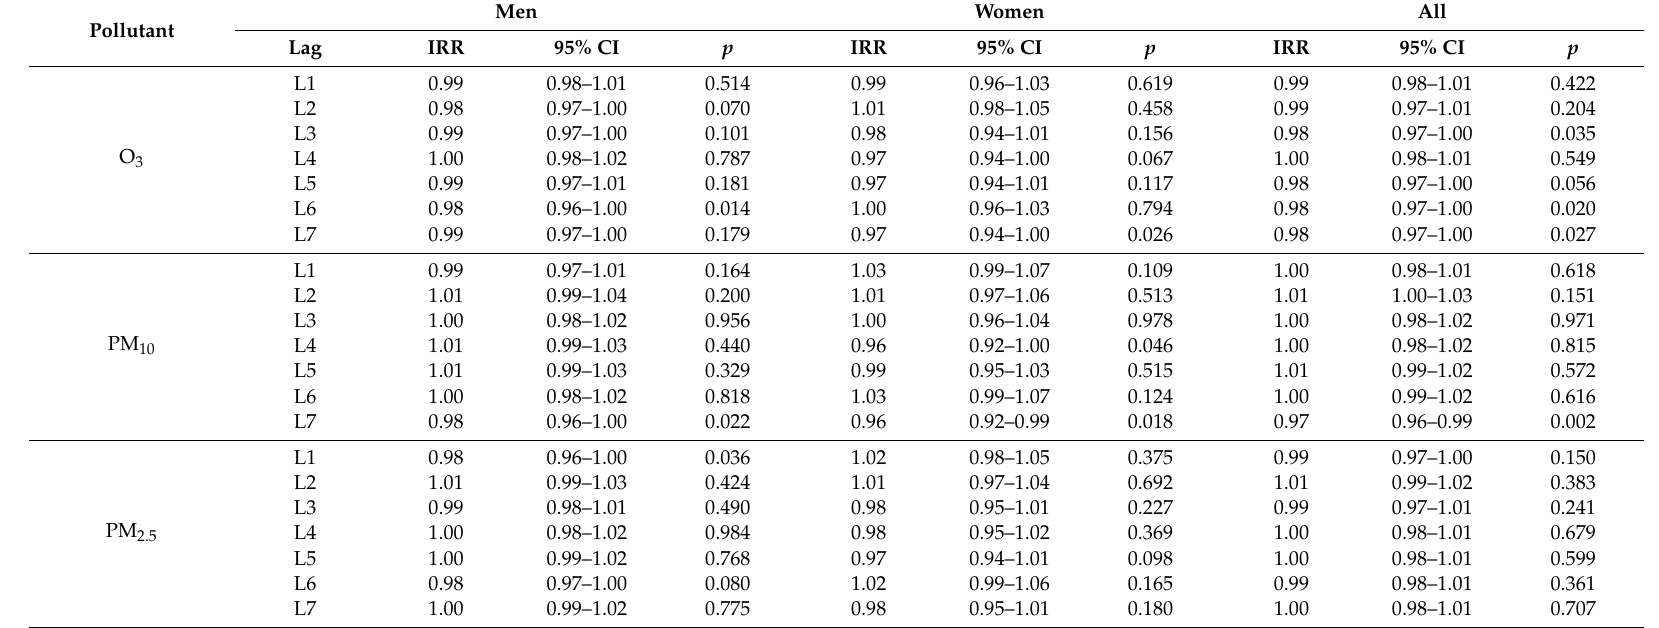
Table 5. Poisson conditional regression models for lagged pollutant e ff ects on daily suicides among men and women in Mexico City, 2000–2016.